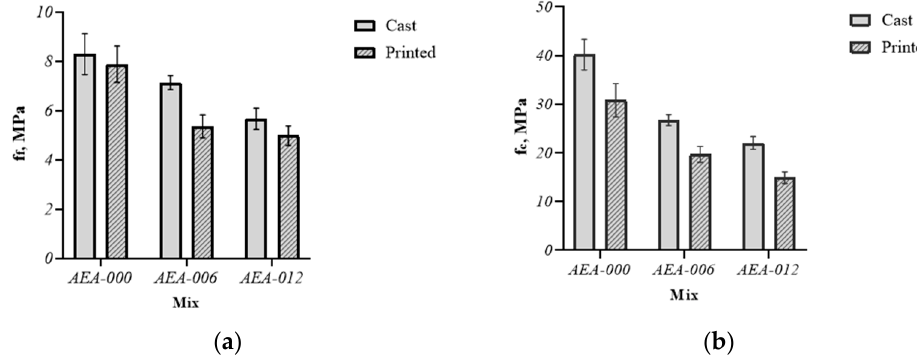
Figure 4. Flexural ( a ) and compressive ( b ) strength of 3D printed and cast samples.